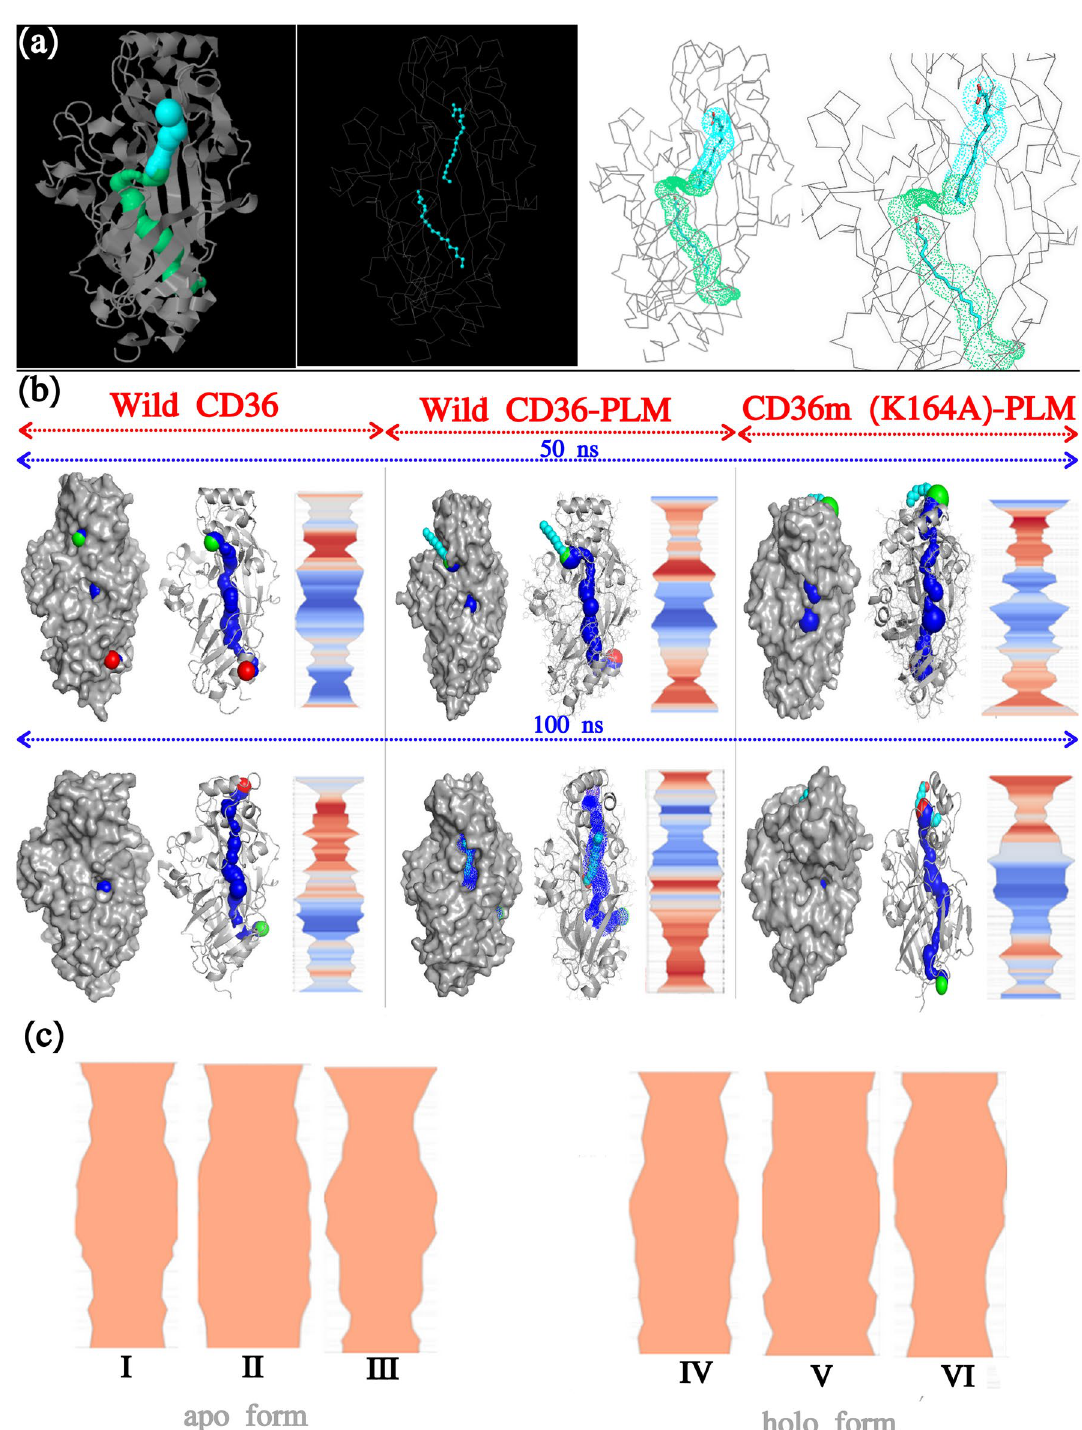
Figure 4. Structure of the studied CD36 with their respective tunnels. ( a ) PLM-bound snapshot, with the crystal structure of the wild-type CD36 (CD36-CIDRα, PDB-ID: 5LGD) depicting fully formed tunnel (identified using CAVER 3.0 PyMOL plugin). The main tunnel is shown by the blue and green surface. ( b ) CHEXVIS was used to analyze snapshots from 50 and 100 ns molecular dynamics simulation for six simulations for wild and mutant type of CD36 in presence and absence of PLM. ( c ) The transport channel of the fatty acid in the apo and holo conformations were identified based on the PCA analysis using CHEXVIS for CD36 WT, CD36WT–PLM and